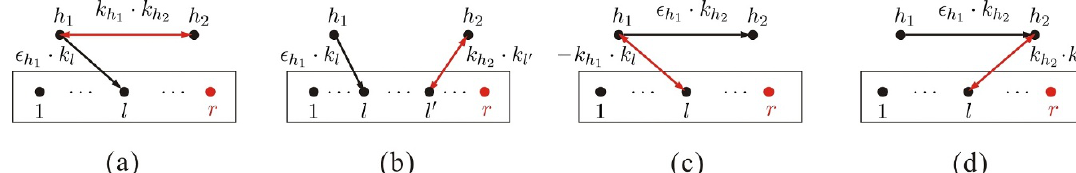
Figure 24 . Graphs (a) and (b) are the skeletons F 0 for the gauge invariance induced identity (3.1) with H = f h 1 ; h 2 g .